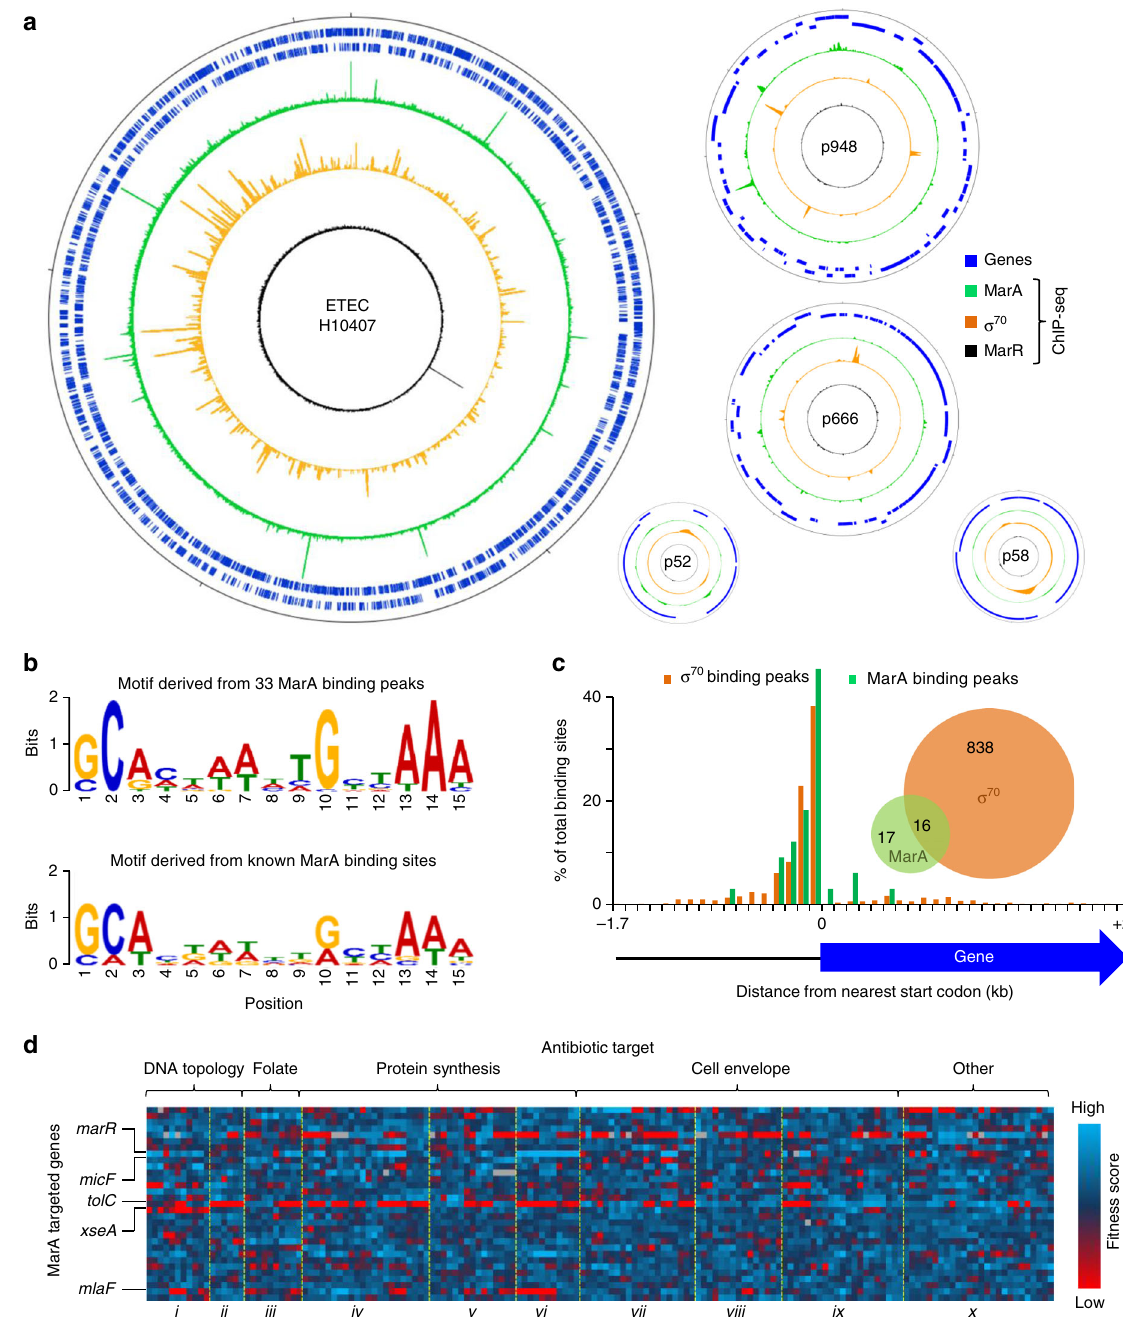
Fig. 1 Global analysis of MarA and its target genes. a Genome-wide distribution of MarA, MarR and RNA polymerase in enterotoxigenic Escherichia coli strain H10407. Plots are shown for the H10407 chromosome and four plasmids. In each plot, the tick mark at the 12 o ’ clock position represents the fi rst base pair (bp) of the DNA element. Subsequent tick marks are spaced by 1 Mbp (chromosome) 10 Kbp (p948 and p666) or 1 Kbp (p58 and p52). In each plot, tracks 1 and 2 (blue lines) show the position of genes, track 3 (green) is the MarA binding pro fi le, track 4 (orange) is the RNA polymerase σ 70 subunit binding pro fi le and track 5 (black) is the MarR binding pro fi le. b DNA sequence motifs recovered from MarA binding peaks. The top panel shows a DNA sequence motif identi fi ed by MEME present in DNA sequences associated with MarA in ChIP-seq analysis. The bottom panel shows a DNA sequence motif generated by aligning experimentally veri fi ed MarA binding sites listed in Ecocyc. c Location of MarA and RNA polymerase binding peaks with respect to genes. A histogram depicting the distance between ChIP-seq binding peaks and the nearest 5 ′ end of a gene; data for MarA binding are in green and data for σ 70 binding are in orange. Each binding peak was allocated to a series of 100 bp bins. The inset is a Venn diagram that illustrates the number of MarA and σ 70 binding peaks that overlap. d Phenotypic landscape of the MarA regulon. The heatmap illustrates fi tness scores 29 of strains lacking MarA target genes ( y -axis) compared to the wild-type parent strain. Strains were grown in the presence of different antibiotics ( x -axis). The antibiotics are clustered according to the cellular process targeted (labelled above heatmap). Drugs are further divided into classes i through x by yellow dotted lines. The classes are as follows: i quinolones, ii non-quinolone topoisomerase inhibitors, iii antifolates, iv macrolides; v aminoglycosides, vi tetracyclines, vii penicillins, viii cephalosporins, ix other cell envelope antibiotics, x miscellaneous. Individual row and column names are provided in Supplementary Fig.